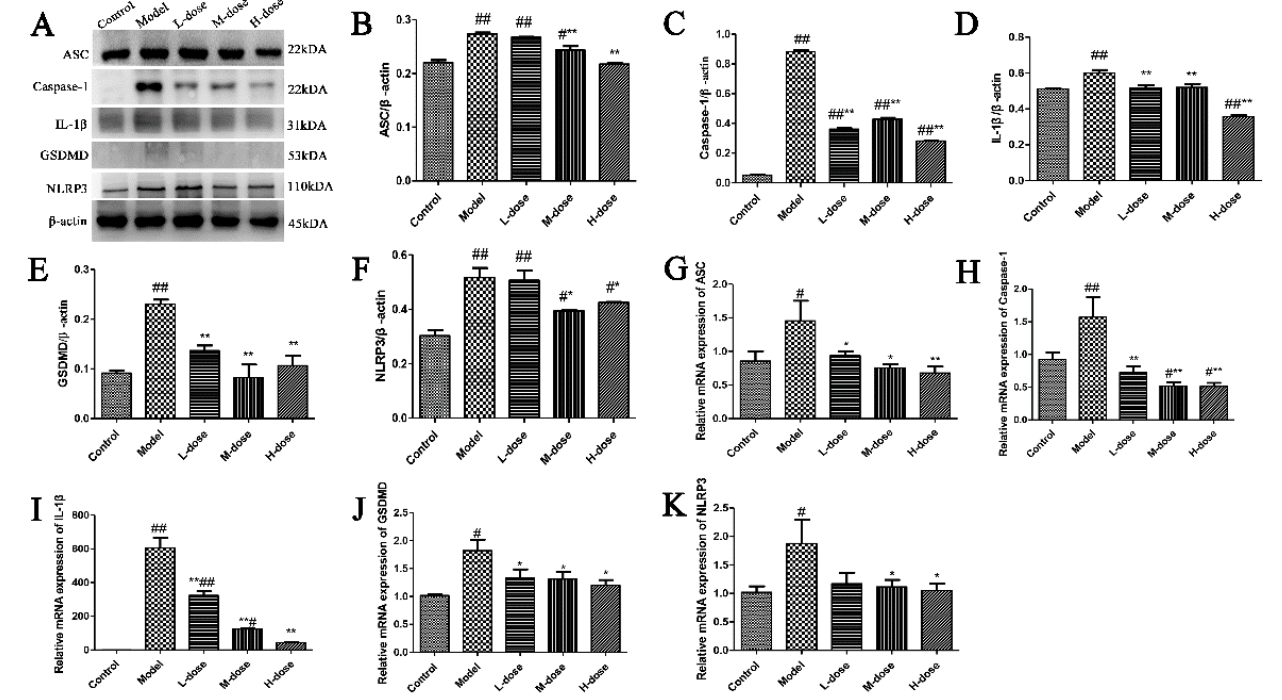
Figure 4. Forsythia suspensa extract may alleviate colitis by inhibiting pyroptosis. ( A – F ) Western blot analysis of ASC, Caspase-1, IL-1 β , GSDMD and NLRP3. ( G – K ) qRT–PCR detection of ASC , Caspase- 1 , IL-1 β , GSDMD and NLRP3 gene expression levels. The results are shown as the mean ± SEM. # p < 0.05, and ## p < 0.01 compared with the control group; * p < 0.05, and ** p < 0.01 com-pared with the model group; #** means # and **; ##** means ## and **.